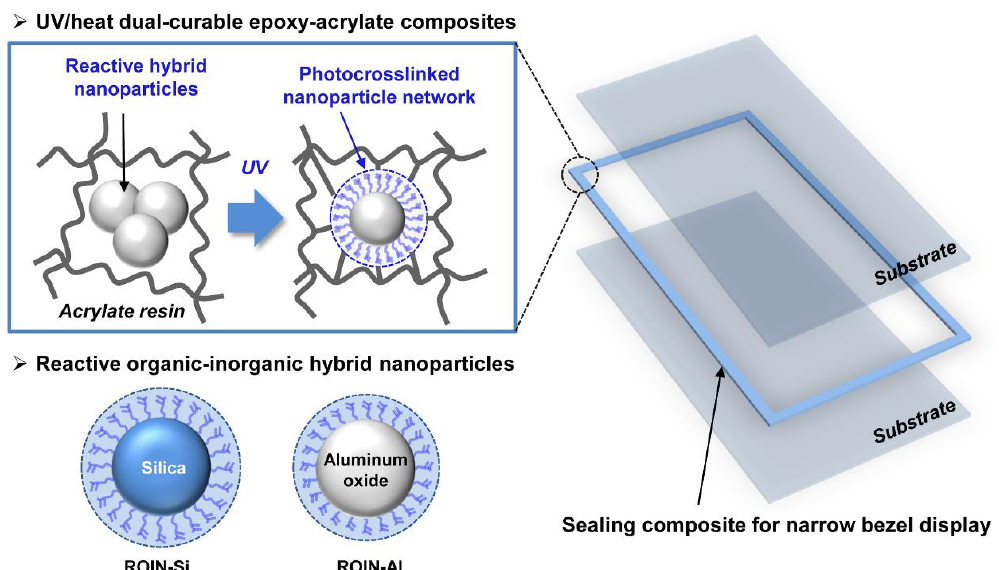
Figure 1. Schematic illustration of UV / heat dual-curable epoxy–acrylate composites embedded with photoreactive organic–inorganic hybrid nanoparticles for narrow bezel display.